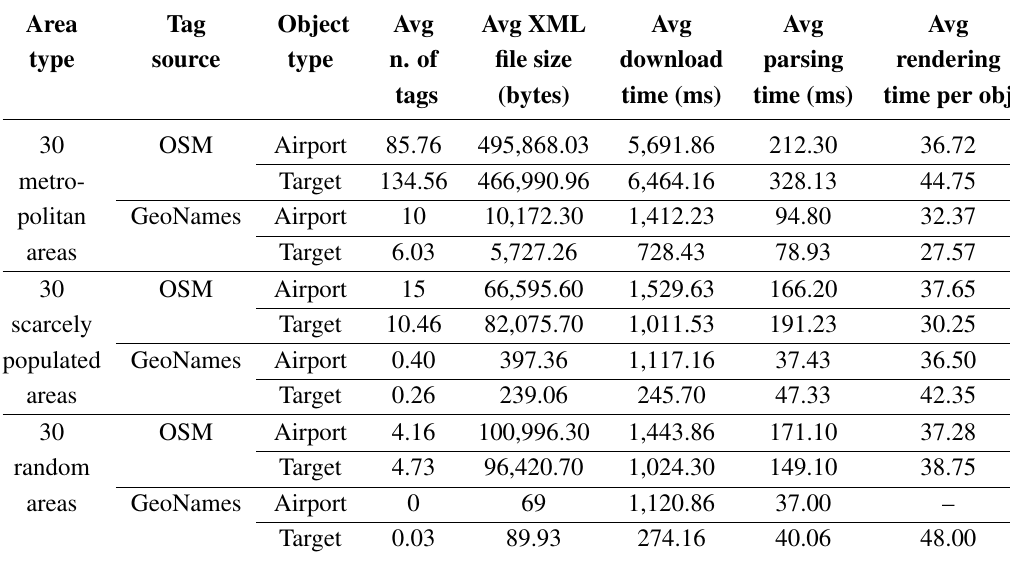
Table 1. Number of tags, XML file size, download times and parsing times for 90 areas of different